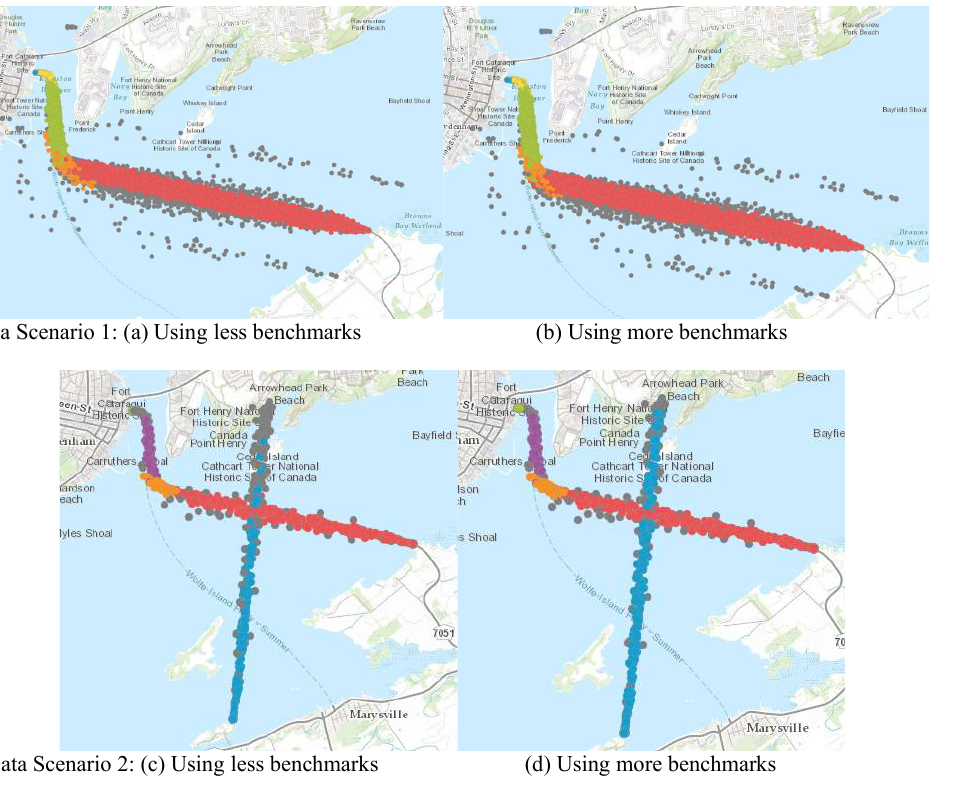
Figure 3. Results comparison of DBSCAN using the Mahalanobis distance metric Figure